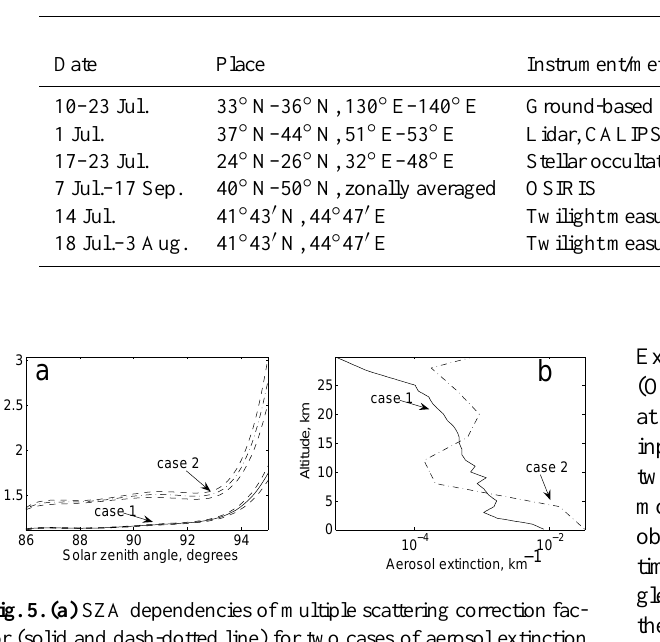
Table 2. Nabro aerosol layer altitude.